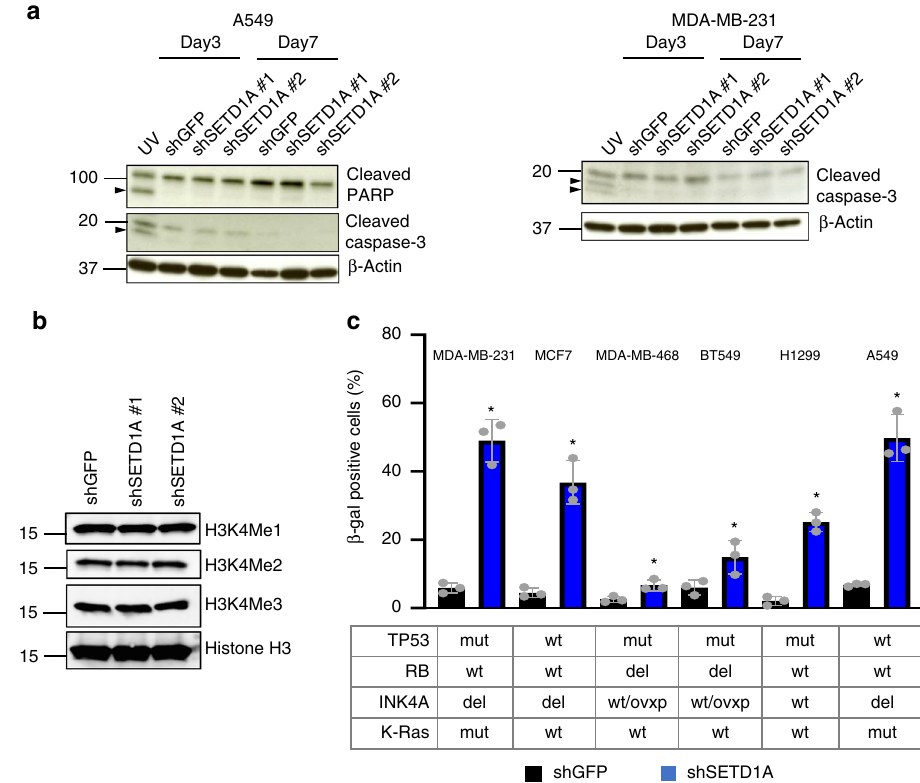
Fig. 2 SETD1A-KD induces senescence independent of p53 and RB status. a SETD1A-KD does not induce apoptosis. Proteins were analyzed after 3 and 7 days of SETD1A-KD for the expression of cleaved caspase-3 (A549 and MDA-MB-231) and cleaved PARP (A549). Cells irradiated with UV are shown as positive controls and the cleaved caspase-3 and cleaved PARP fragments in the positive control are highlighted with arrows. ß-actin serves as the loading control. Source data are provided as a Source Data fi le. b SETD1A-KD does not change global H3K4 methylation. shGFP- and SETD1A-KD-MDA-MB- 231 cells were analyzed for H3K4Me1, H3K4Me2, H3K4Me3 and total histone-3 protein expression. Source data are provided as a Source Data fi le. c Bar graphs show quanti fi cation of ß-gal positive cells (Mean + SD) in multiple breast cancer (MCF7, MDA-MB-468, BT549, MDA-MB-231) and lung cancer (HT1299, A549) cell lines infected with shSETD1A and shGFP. The mutational status of p53 , RB , p16 and K-Ras in these cell lines is shown below. wt wild type, del deletion, mut mutant, wt/ovxp wildtype or overexpressed. shSETD1A av represents the mean of cells infected with two different shSETD1A constructs. Data from three independent experiments are presented as Mean + SD; * p < 0.05 by two-tailed unpaired Student ’ s t test. Source data